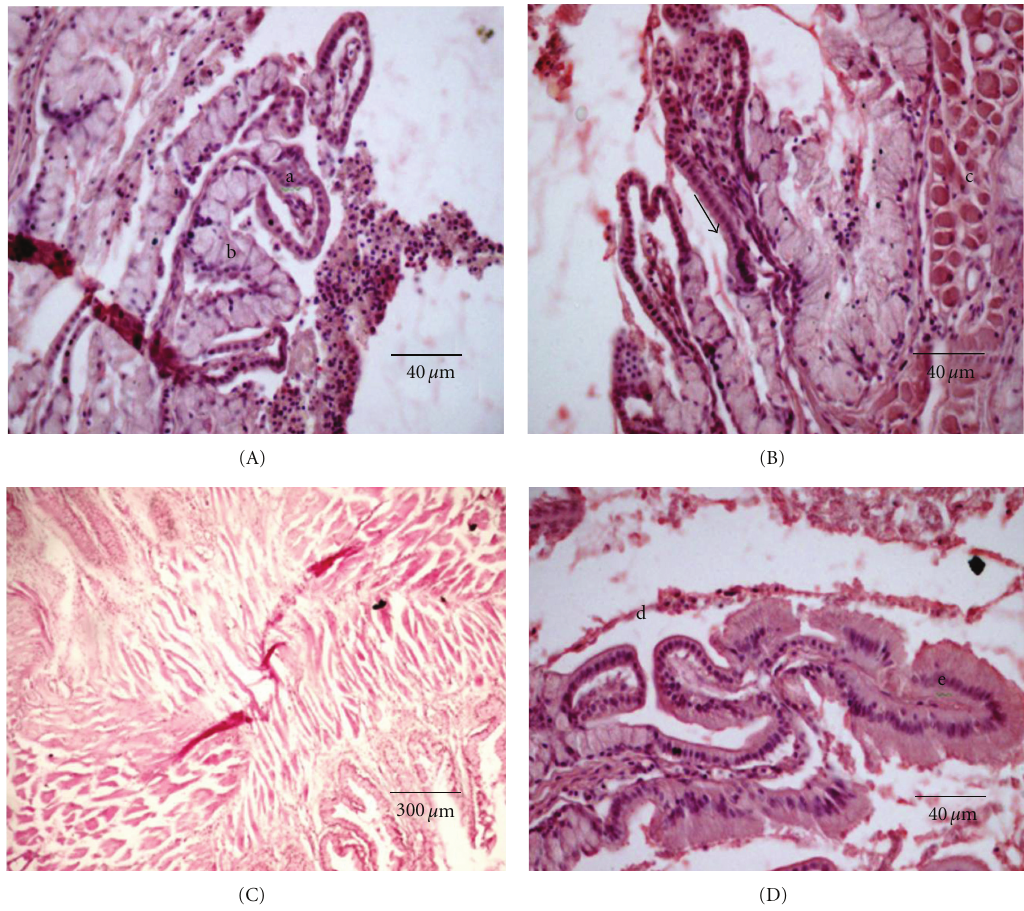
Figure 3: Esophagus of S. fuscus. (A) Mucosa with folds consisting of (a) cubic epithelium and (b) mucous glands; (B) mucosa with a tubular mucous secretory gland (arrow) and (c) muscle layer consisting of striated skeletal muscles; (C) esophagus sphincter; (D) esophagus-stomach region showing cubic epithelium of esophagus (d) and cylindrical epithelium of the stomach